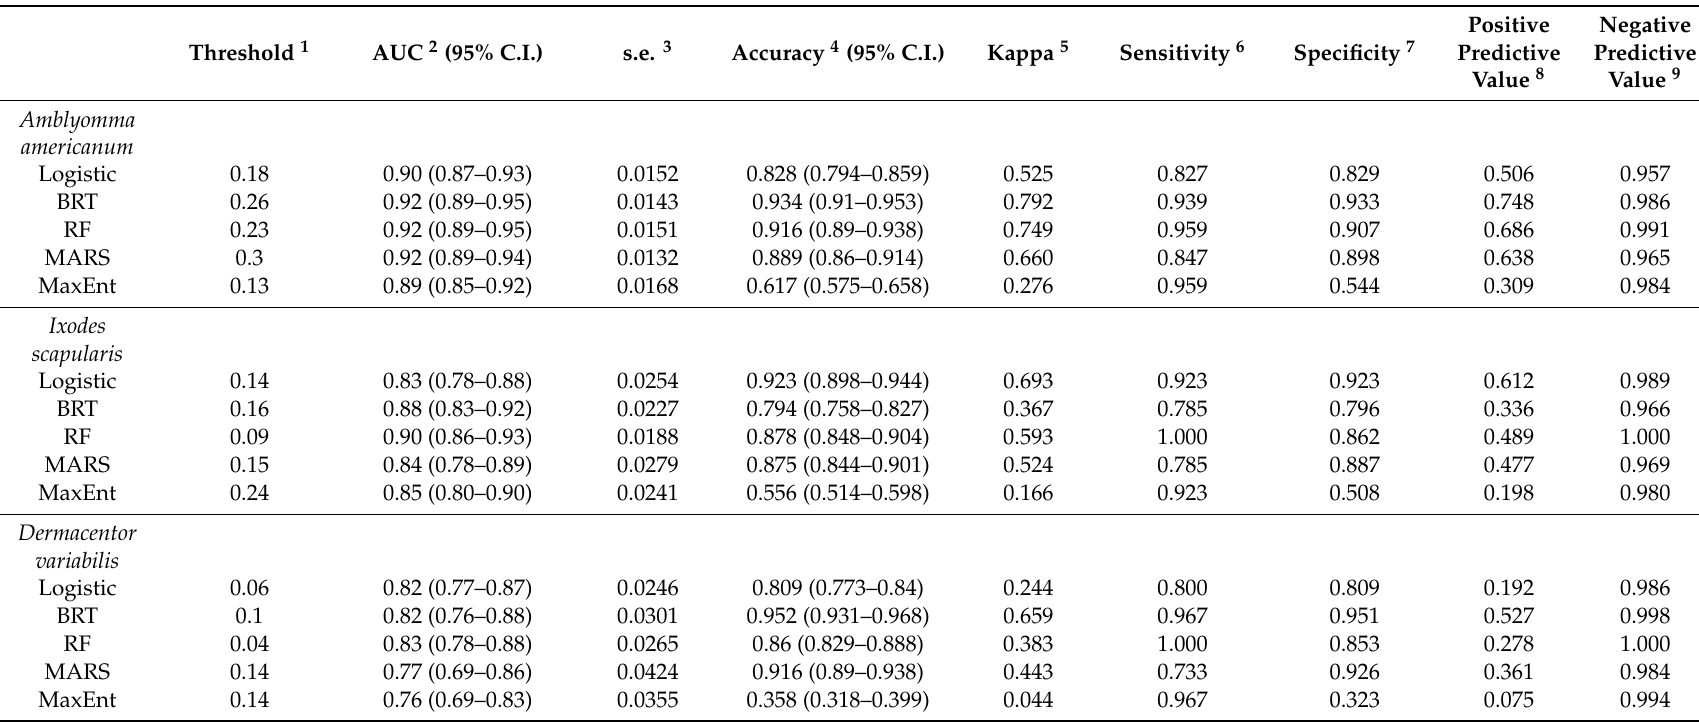
Table 4. Performance metrics associated with each of the five modeling algorithms for each species. AUC ranges correspond to the upper and lower bounds of a 95% CI calculated from across the 10-fold cross